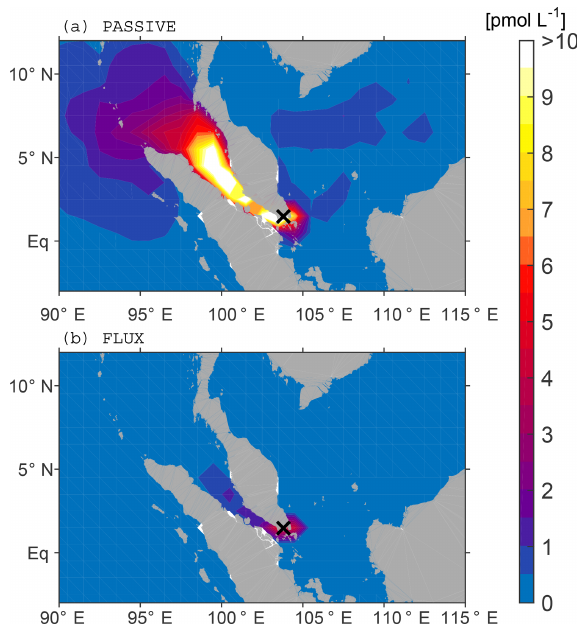
Figure 8. Surface bromoform concentration in Singapore for the MODERATE scenario averaged over 1 year. (a) PASSIVE analysis without loss rates. (b) FLUX analysis with